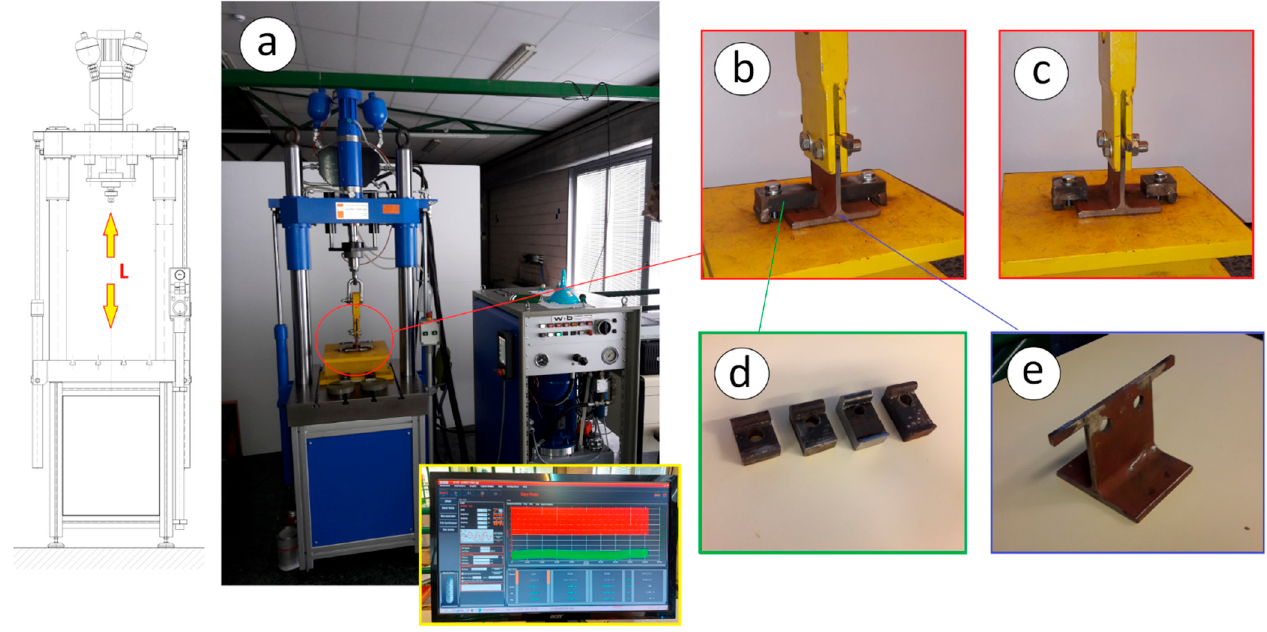
Figure 6. Laboratory tests: ( a ) universal hydraulic tension-compression fatigue testing machine; ( b ) long clamp test; ( c ) short clamp test; ( d ) clamp sizes used; ( e ) specimen of T-shape made from an IPE220.